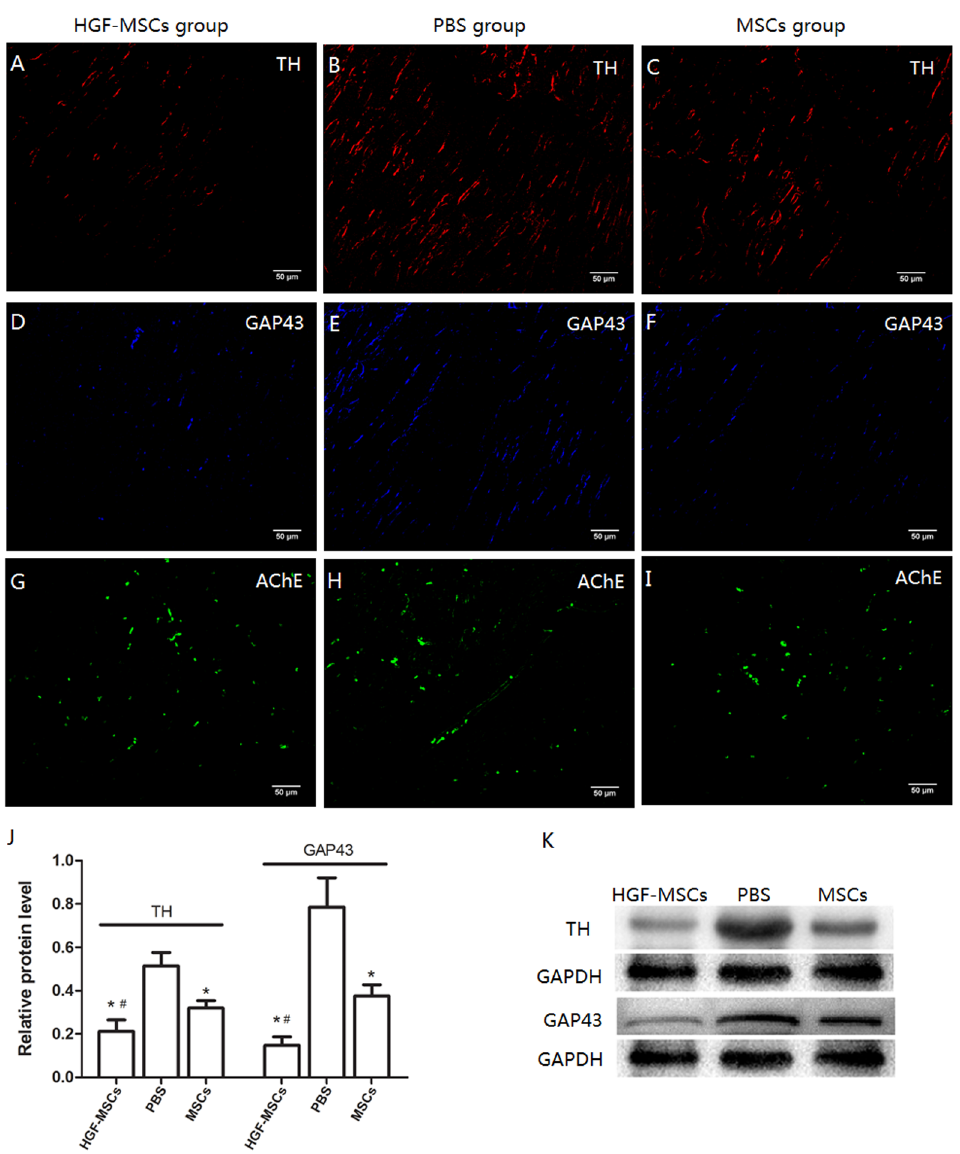
Figure 4. Neural remodeling. (A–C) Sympathetic nerve fibers were detected based on TH-positive immunostaining. (D–F) The GAP43 expression profile was specific for nerve sprouting. (G–I) The AChE-positive fibers indicated the parasympathetic distribution. MI-induced sympathetic sprouting and hyper-innervation were significantly attenuated in the HGF-MSC group compared with the PBS group. These effects appeared to be weaker between the MSC and PBS groups. However, the parasympathetic nerves displayed no substantial differences between the groups. (J–K) Western blot analysis confirmed a decrease in TH and GAP43 protein expression levels in the HGF-MSC group compared with the other two groups. A similar but smaller effect was detected in the MSC group compared with the PBS group. All values were normalized to that of the control. *, P , 0.01 vs. the PBS group; # , P , 0.01 vs. the MSC group. doi:10.1371/journal.pone.0111246.g004 Table 1. Density of Nerve Staining in the Infarction Border Zone at 4 Weeks after Cell Delivery.